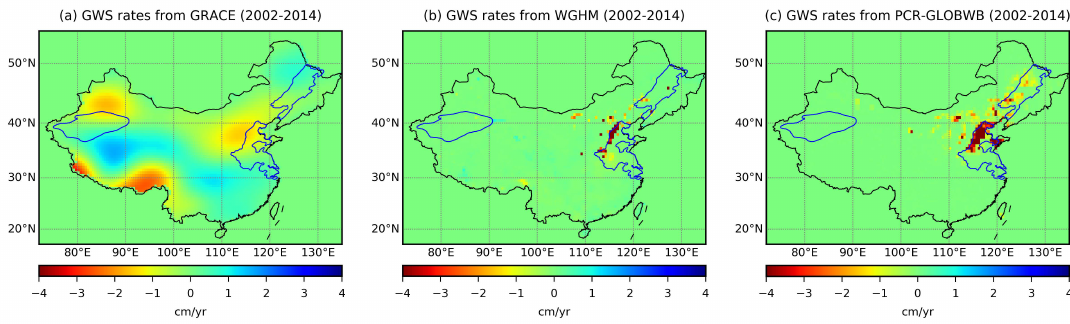
Figure 2. GWS rates over China from ( a ) GRACE; ( b ) WGHM; and ( c ) PCR-GLOBWB during 2002–2014. Blue lines highlight the three main aquifer basins in